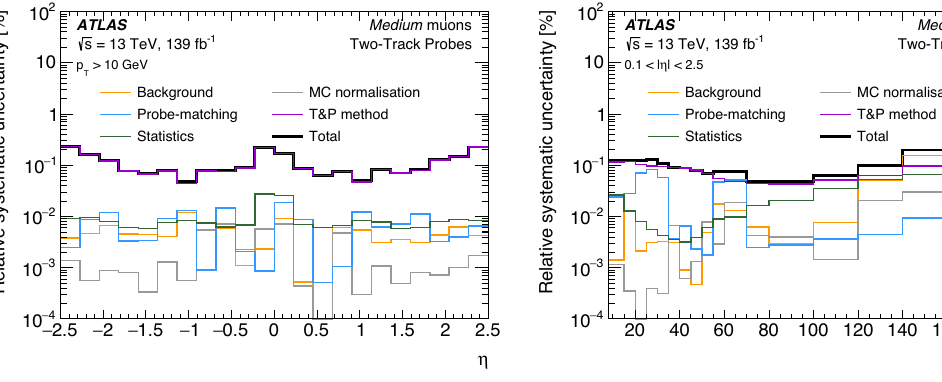
depicted as Background is the sum in quadrature of the Template shape , (cid:15) - SC , and Background fit uncertainties, whereas the MC normalisation comprises the Cross-section and Luminosity uncertainties. The total uncertainty is the sum in quadrature of the individual